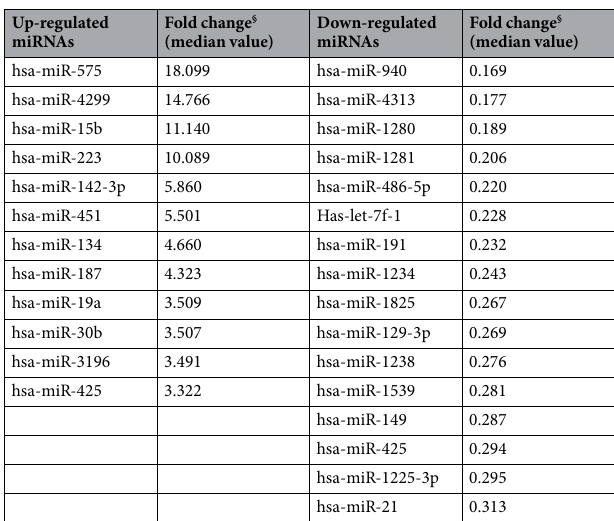
Table 1. Differentially expressed miRNAs in plasma from AOSD patients compared with healthy controls, identified by miRNA microarray analysis. AOSD: adult-onset Still’s disease; miRNA: microRNA. § Fold change: if the number > 3.00 or < 0.330, the difference is considered